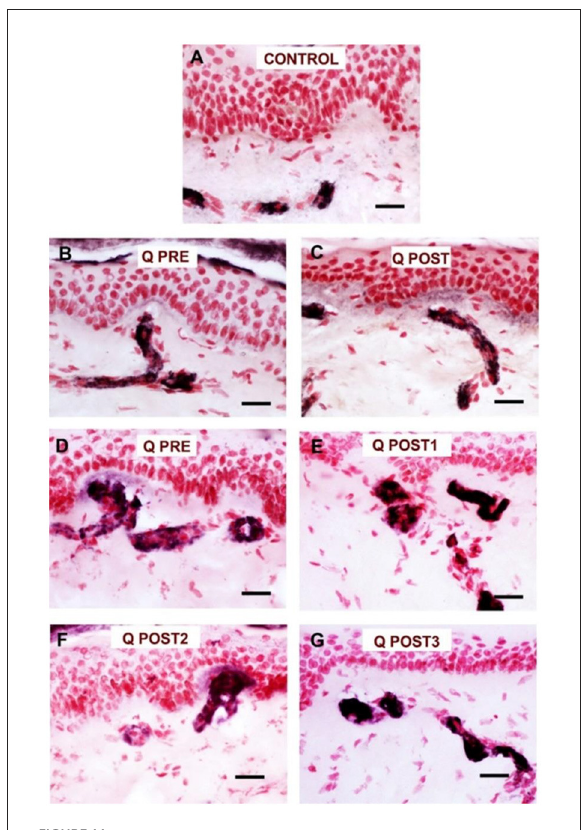
FIGURE11 Staining for vWF in NPDPN Q + SOC and PDPN Q + SOC after of Capsaicin 8% patch Qutenza (Q) treatment. (A) Control skin biopsy from a human healthy volunteer (vessels stained in black). (B) NPDPN Q + SOC: Skin biopsy from subject pre–treatment (Q PRE); note increase in vessels compared to control. (C) Skin biopsy section from same NPDPN Q +